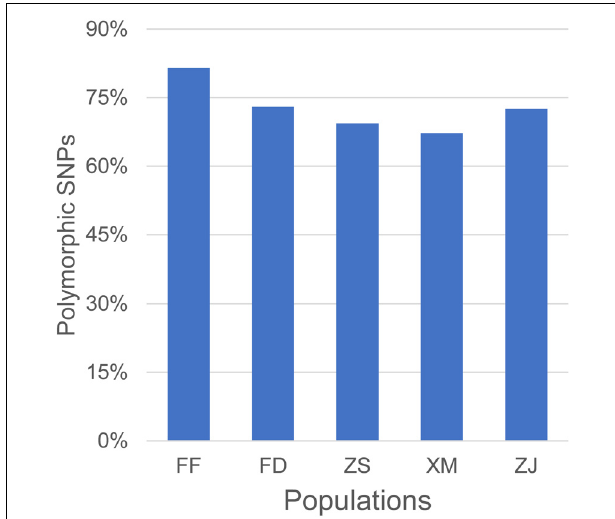
FIGURE 4 | Evaluation of single-nucleotide polymorphism (SNP) array by polymorphic rate of large yellow croaker from different populations. The X -axis represents different populations of large yellow croakers. FD, Fuding; DY, Dayu; XM, Xiamen; ZJ, Zhanjiang; ZS, Zhoushan.